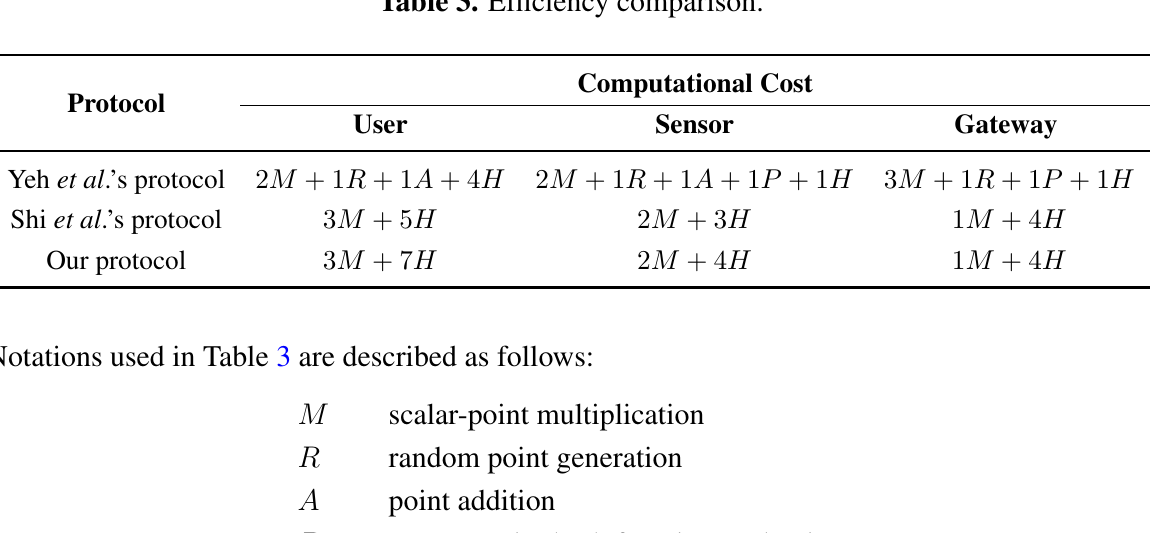
Table 3. Efficiency